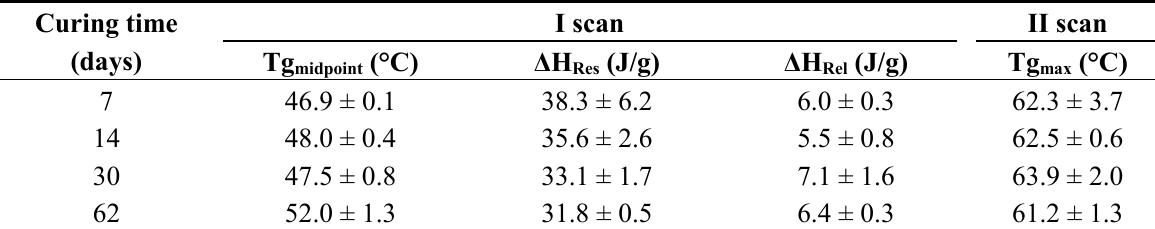
Table 1. Tg midpoint , ΔH Res , ΔH Rel and Tg max values measured on cold-cured epoxy samples (thickness = 5 mm), cured at room temperature for different time spans, by dynamic DSC